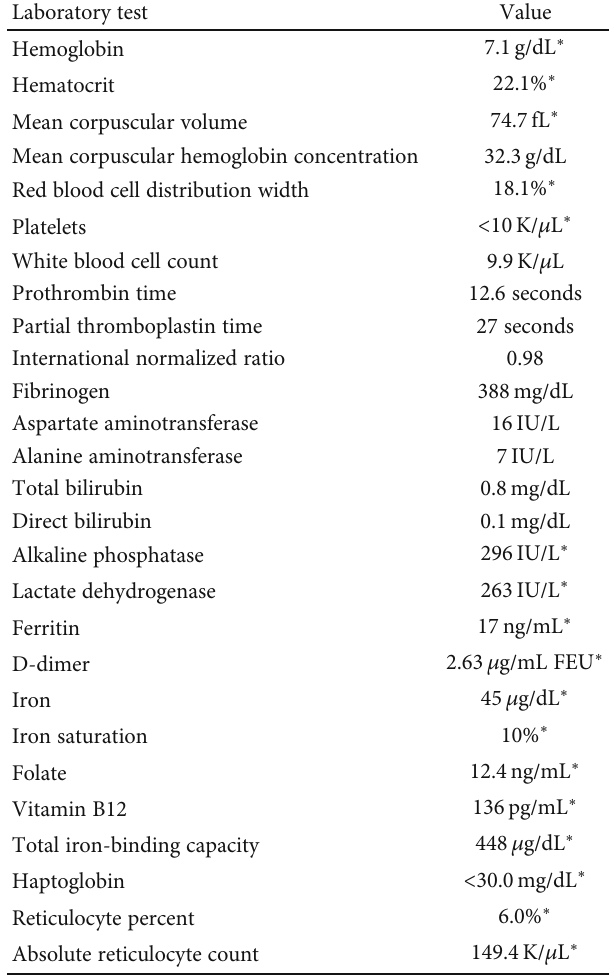
Table 1: Initial laboratory